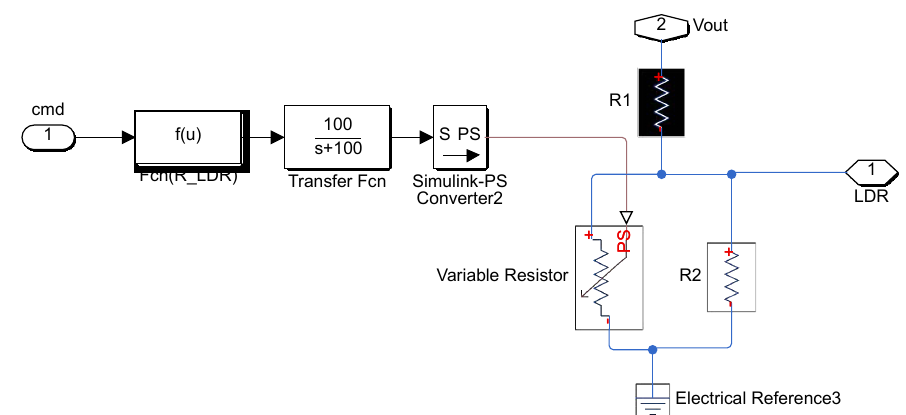
Figure 15. Circuit simulation model for the LDR.